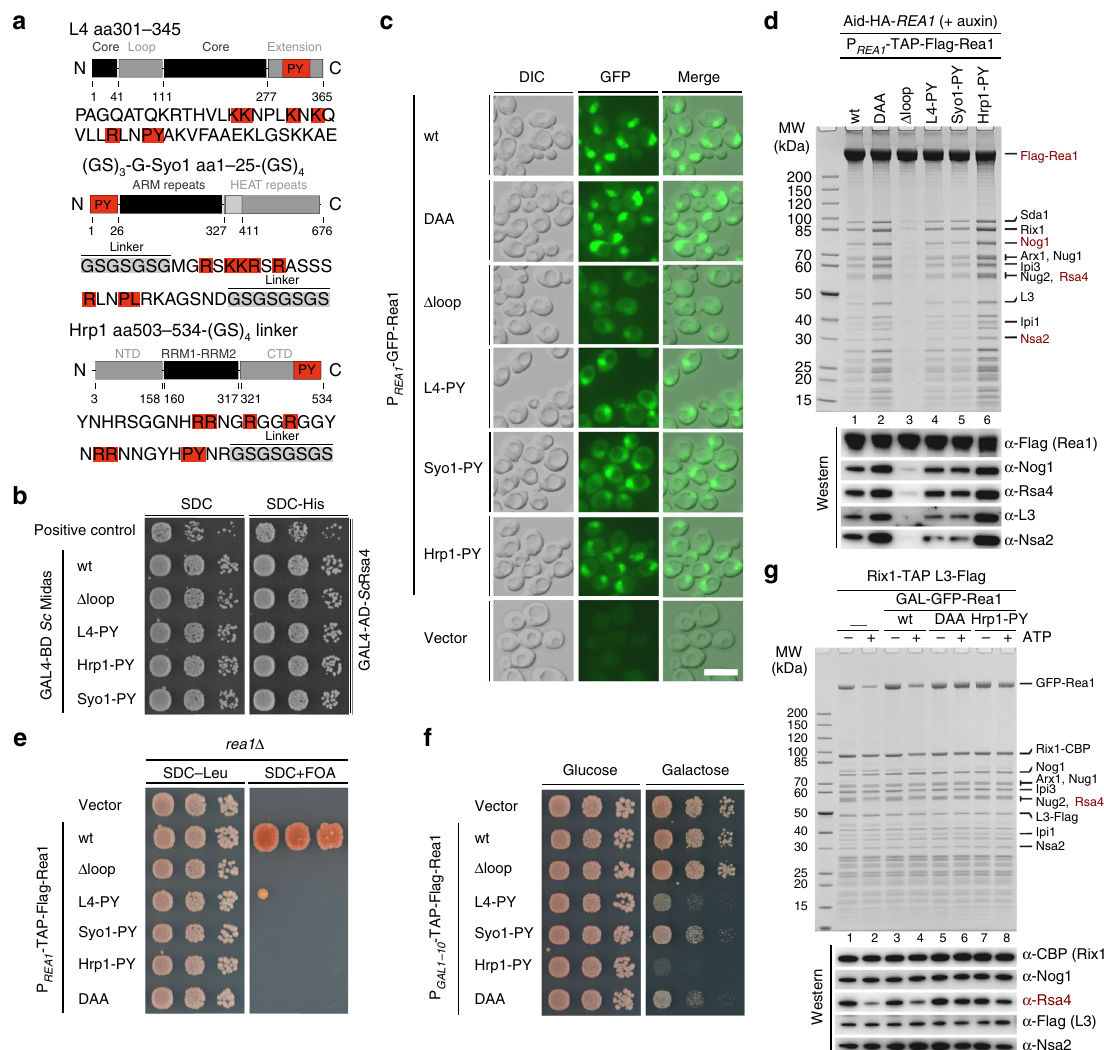
Fig. 6 Nuclear import of Rea1 can be restored by a heterologous PY-NLS but still lacks Rea1-MIDAS loop-speci fi c functions. a The PY-NLS containing Rea1- MIDAS element II loop (residues 4657 – 4696) was exchanged with PY-NLS-containing regions derived from either L4, Syo1, or Hrp1, whose domain organizations are shown. The different PY-NLS-containing fragments used to insert into the Rea1-MIDAS Δ loop construct are highlighted in red and their amino acid sequences are shown below. Additional linker sequences are labeled and marked in gray. b Yeast two-hybrid analysis of the interactions between Rsa4 and the indicated Rea1-MIDAS constructs from S. cerevisiae . c Subcellular localization of the indicated N-terminally GFP-tagged Rea1 constructs under control of the endogenous REA1 promotor was monitored by fl uorescence microscopy. Nomarski (DIC), GFP and merged images are shown. Scale bar: 5 µ m. d Af fi nity puri fi cation of the Rea1-MIDAS Δ loop constructs containing foreign PY-NLSs from L4, Syo1, or Hrp1. The indicated Rea1 constructs were fused to an N-terminal TAP-Flag tag under the endogenous REA1 promotor, which were transformed into an AID-HA- REA1 degron strain. Rea1 depletion was induced by addition of auxin (500 µ M fi nal concentration) for 2 h before harvesting and subsequent af fi nity puri fi cation. Final eluates were analyzed by SDS-PAGE following Coomassie staining or by western blot analysis using the indicated antibodies. e The indicated Rea1 constructs were transformed in a rea1 Δ shuf fl e strain and the viability of the respective mutants assessed on 5-FOA-containing plates. f The indicated Rea1 constructs under control of the GAL1-10 promoter or an empty vector control were transformed in a wild-type strain (expressing endogenous REA1 ) and cell growth was monitored on plates containing glucose (SDC-Leu, left) or galactose (SGC-Leu, right). g Rix1-TAP pre-60S particles isolated after overexpression of the indicated Rea1 constructs under control of the GAL1-10 promotor (lanes 3 – 8) were incubated with 2.5 mM ATP (lanes 2, 4, 6, 8) or left untreated (lanes 1, 3, 5, 7) before re-isolation via L3-Flag. Final Flag-eluates were analyzed by Coomassie staining or by western blotting using the indicated antibodies. Source data are provided as a Source Data fi le (Fig. 6a) 43 – 45 . Insertion of either of these heterologous PY-NLSs into the Rea1 Δ loop construct, which did not impair binding to Rsa4 (Fig. 6b), not only restored nuclear import of Rea1 into the nucleus (Fig. 6c), but also allowed assembly of Rea1 into pre-60S structs were not able to complement the otherwise lethal rea1 Δ